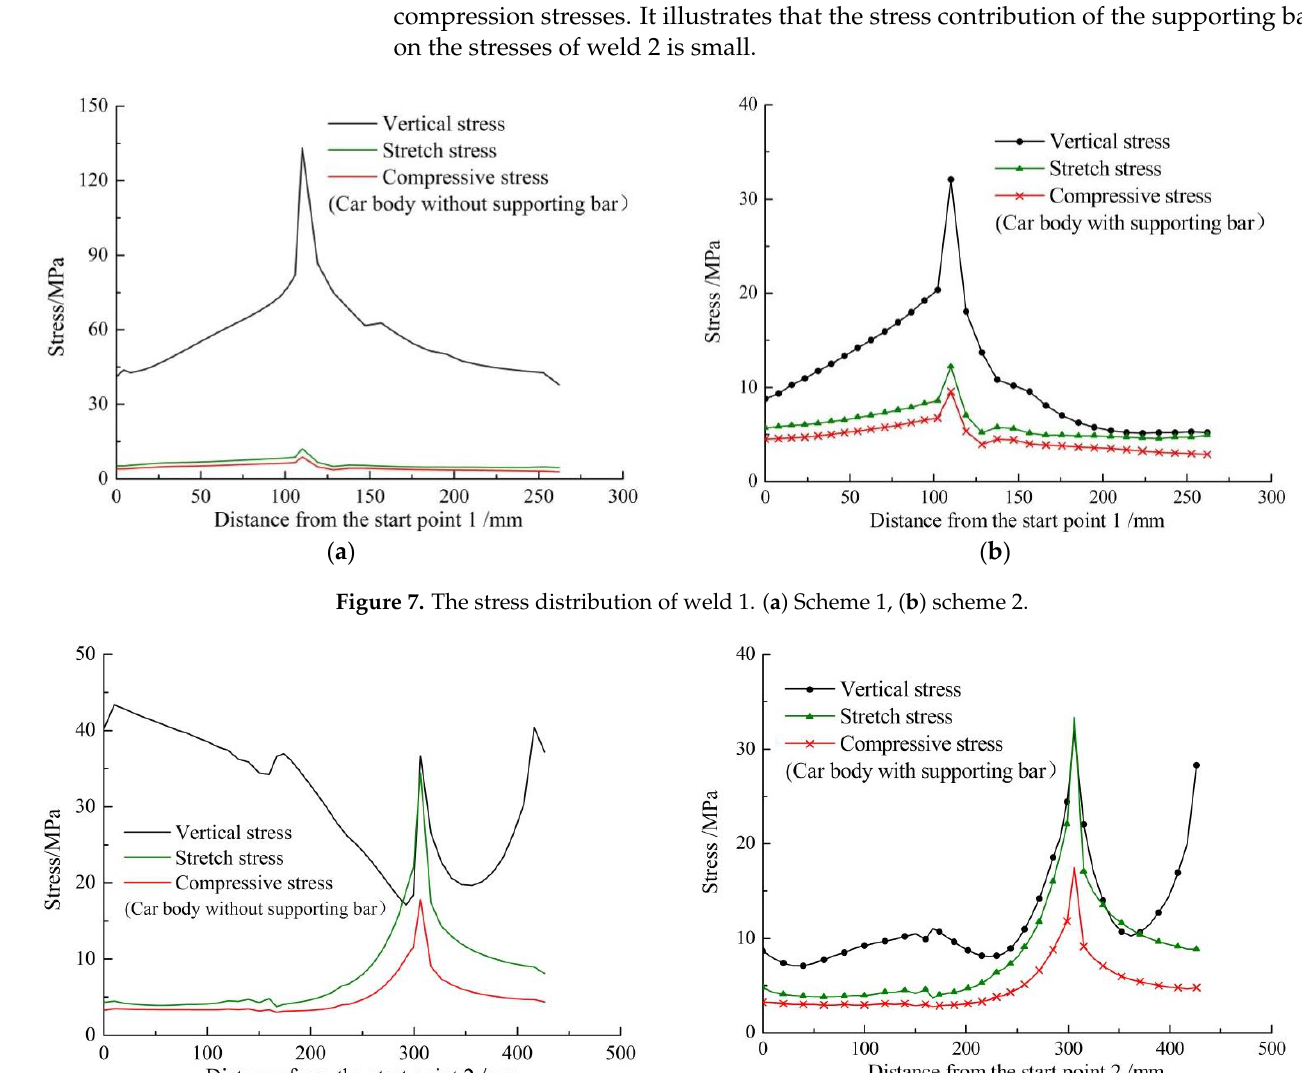
Figure 7. The stress distribution of weld 1. ( a ) Scheme 1, ( b ) scheme 2.